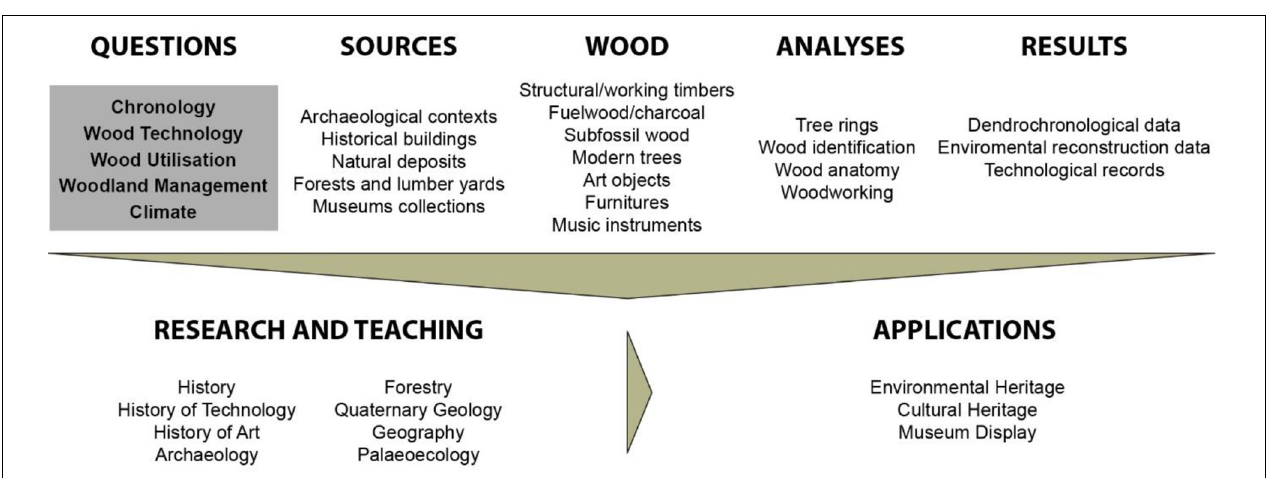
FIGURE 12 | Overview of the research discipline dendroarchaeology including research questions, wood sources, analyses and results that are relevant for different research fields and